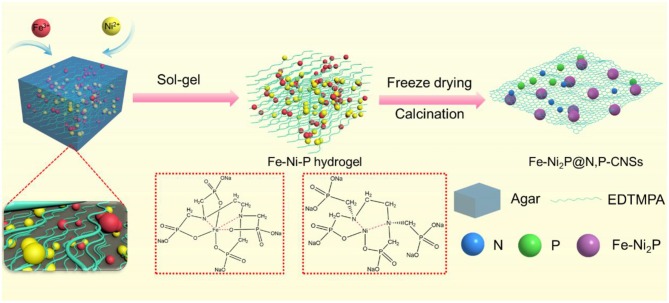
Schematic illustration of the preparation procedure of Fe-Ni2P@N,P-CNSs catalyst.